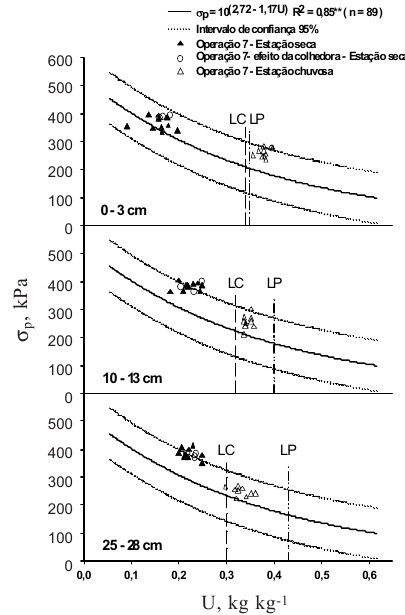
Figura 6. Modelo de capacidade de suporte de carga para o Latossolo Amarelo distrófico típico nas camadas de 0–3, 10–13 e 25–28 cm com seus respectivos limites de contração (LC) e de plasticidade (LP). Os pontos representam as pressões de preconsolidação determinadas após as operações de todos os equipamentos na estação seca e na chuvosa (Operação